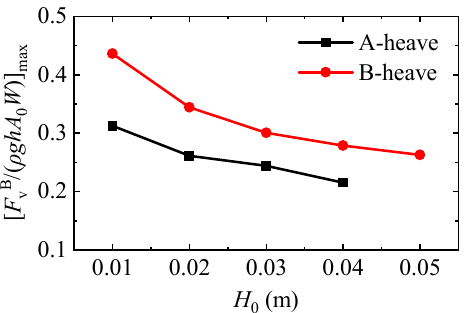
Figure 14. Variations of the normalized largest vertical wave forces on Box B, [ F vB /( ρ ghA 0 W )] max , with the incident wave height.